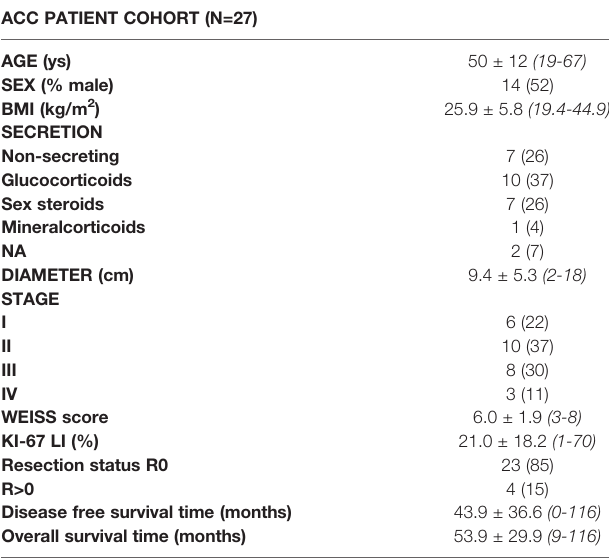
TABLE 1 | Clinical characteristics of the ACC